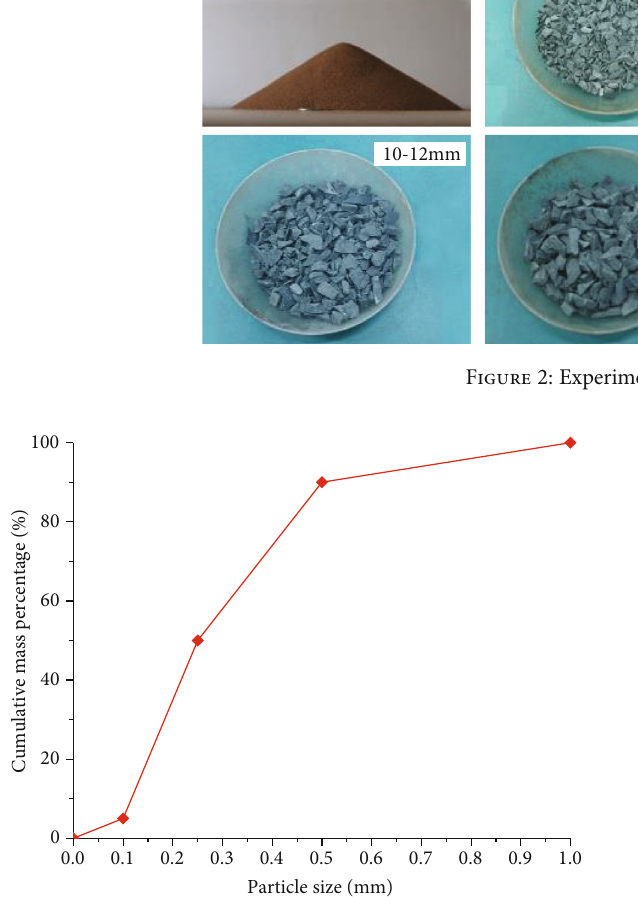
Figure 3: Grain size distribution curve of the aeolian